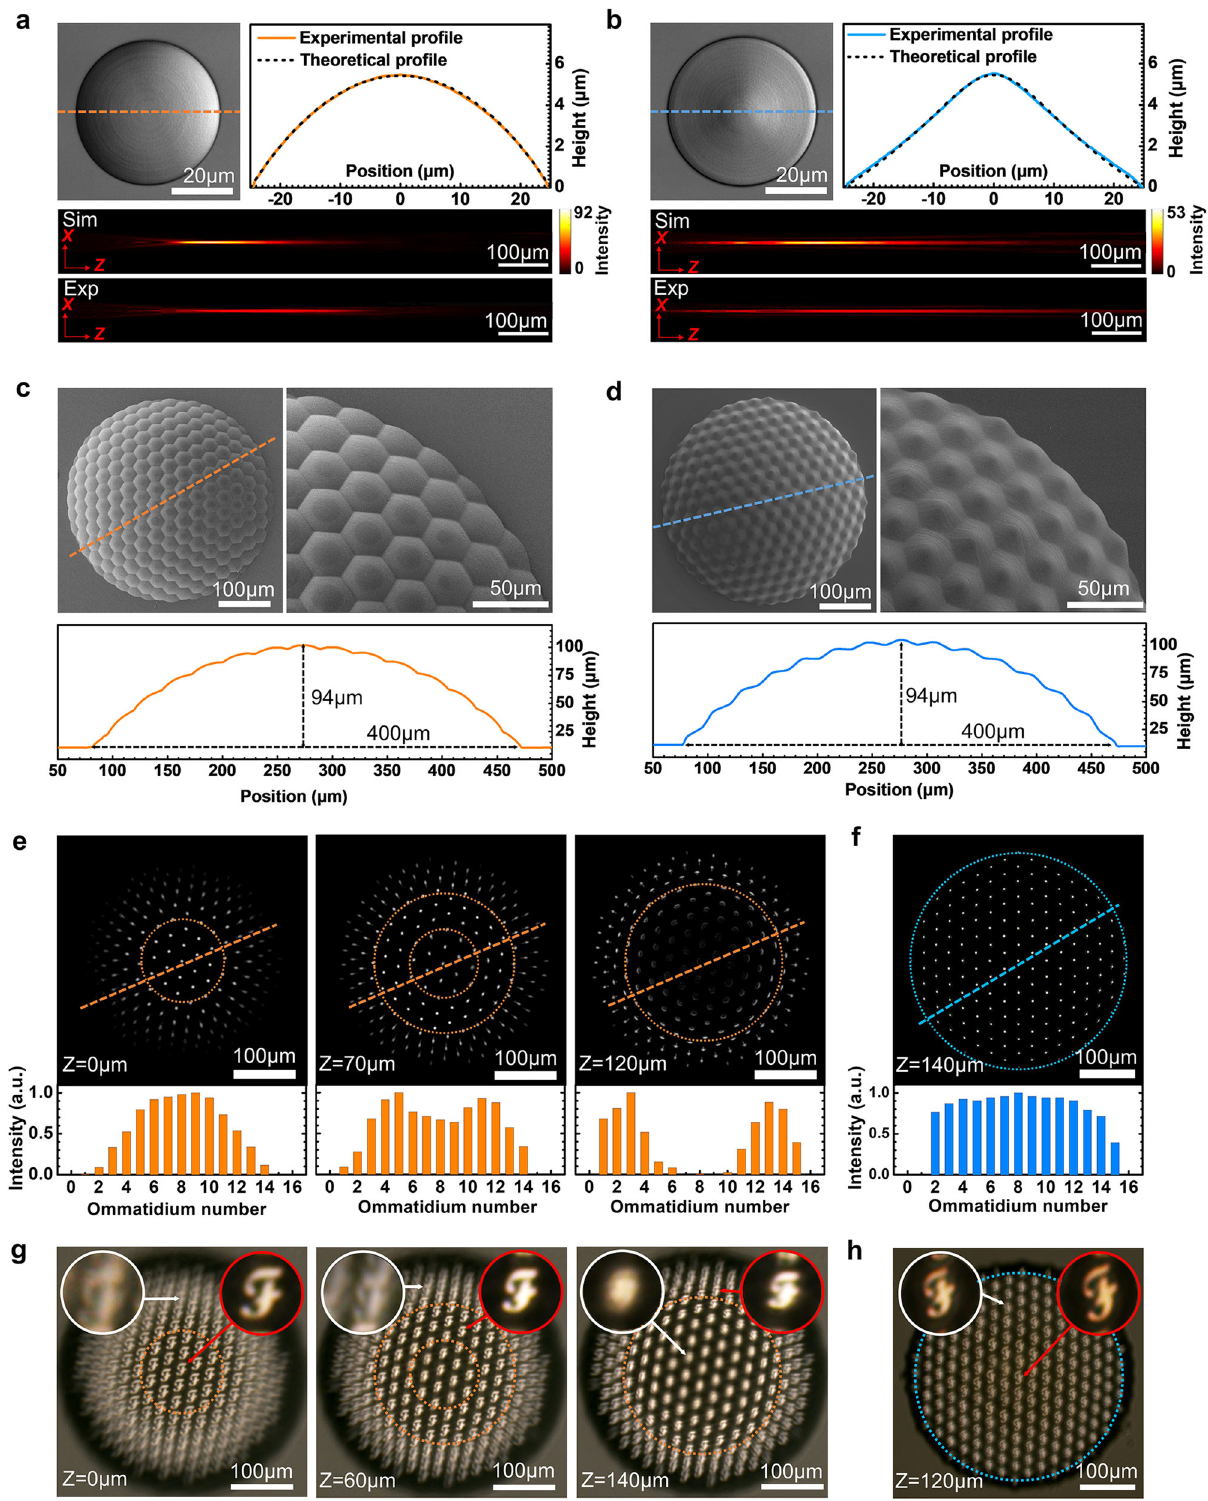
Fig. 2 | Comparisons between spherical and logarithmic CEs. a , b Optical properties of a a single spherical lens (SL, radius: 25 μ m, focal length: 355 μ m) and b a logarithmic lens (LL, radius: 25 μ m, focusing range: 100 – 800 μ m). The top-left images are microscopic images; the top-right results are cross-sectional pro fi les; the bottom images are simulative (Sim) and experimental (Exp) focusing intensity distributions along the opticalaxis. c , d Morphologies of the as-prepared spherical